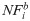
Comparisons between the AAENM and CGENM.Comparisons of the fluctuations between each nucleotide in the AAENM (black curves) and CGENM (gray (Red) curves) for a typical 50-bp random DNA sequence (5’—GAGGCTAAAGTCTATTTAGACCGGAGTTGACGTGGAAGCCCGGCTAGTCT—3’). (a) NF
i and CF
i, (b) NFib and CFib, (c) NFis and CFis, and (d) NFit and CFit. Helical parameter set (i) (Table 2) was used for both models. The nucleotide indices in (a) to (d) are given in the same order shown for (e). ρ indicates the Pearson correlation coefficient of the profiles between the two curves.